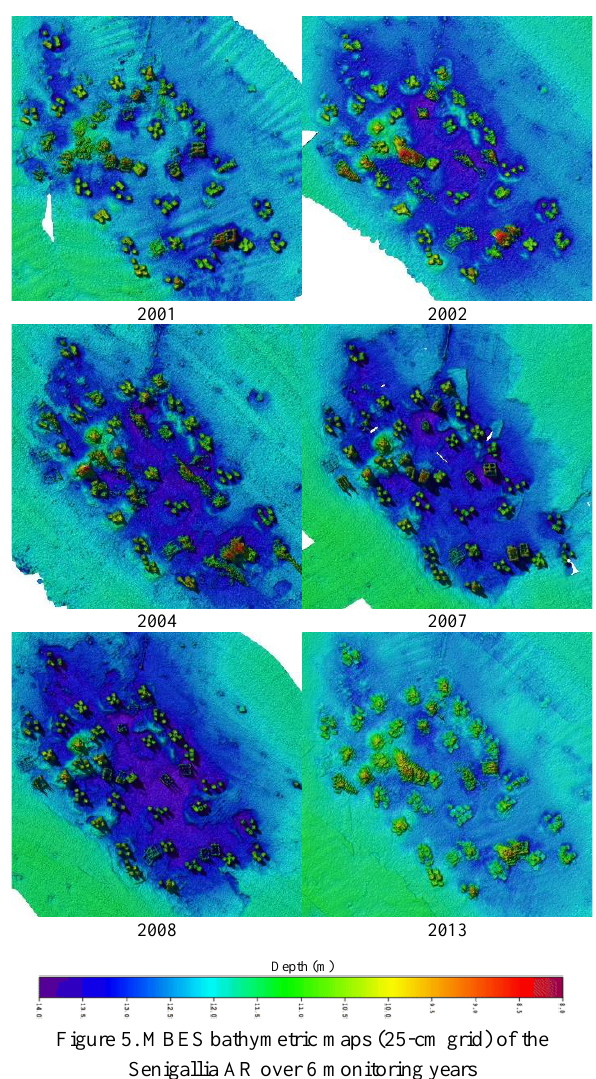
Figure 5. MBES bathymetric maps (25-cm grid) of the Senigallia AR over 6 monitoring